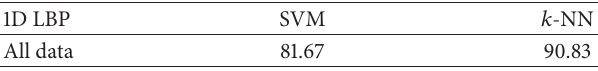
Table 12: The performance of classifiers for VSVL model when the 1D LBP scheme is used for feature extraction.